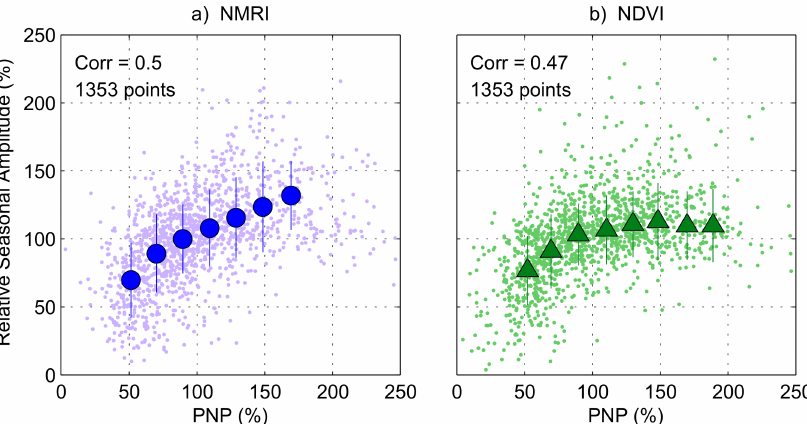
Figure 6. NMRI ( a ) and NDVI ( b ) relative amplitude (small dots) versus the corresponding 6-month Percent of Normal Precipitation (PNP). The large symbols are the averaged values over 40% wide PNP bins incremented every 20%. Each bin has a number of points